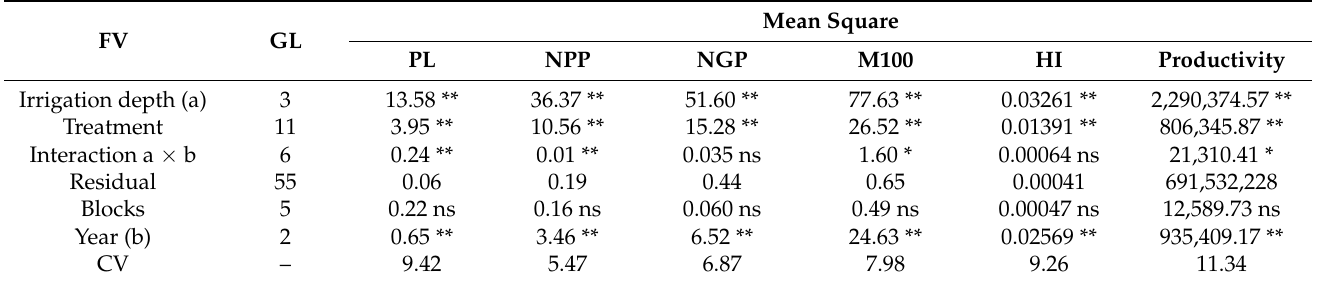
Table 2. Analysis of variance of pod length (PL), number of pods per plant (NPP), number of grains per pod (NGP), mass of 100 grains (M100), harvest index (HI), and cowpea productivity, under different irrigation depths in